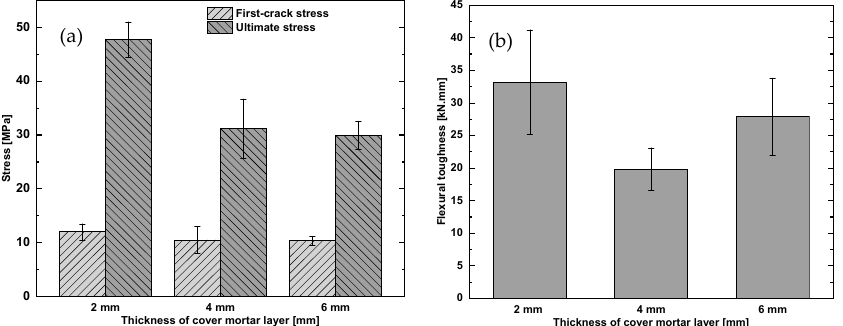
Figure 9. The mechanical strength of one textile layer reinforced specimens containing 5% BF with respect to the mortar cover thicknesses: ( a ) flexural stress; ( b ) flexural toughness.